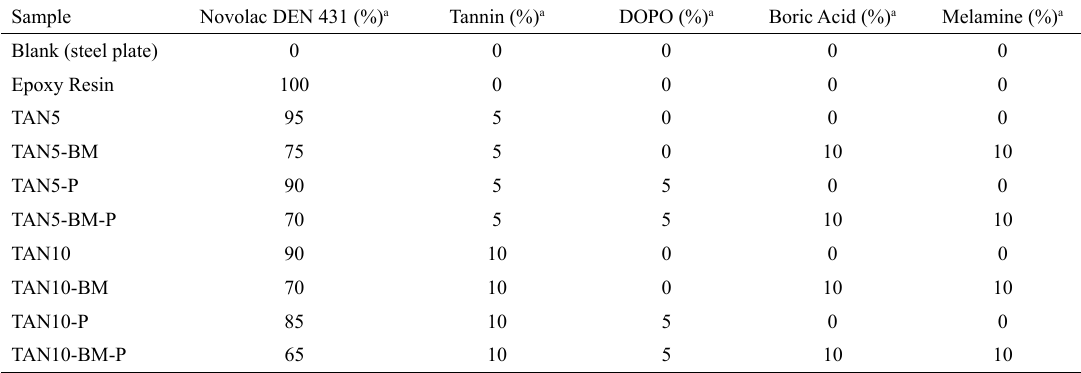
Table 1. Composition of intumescent coatings.